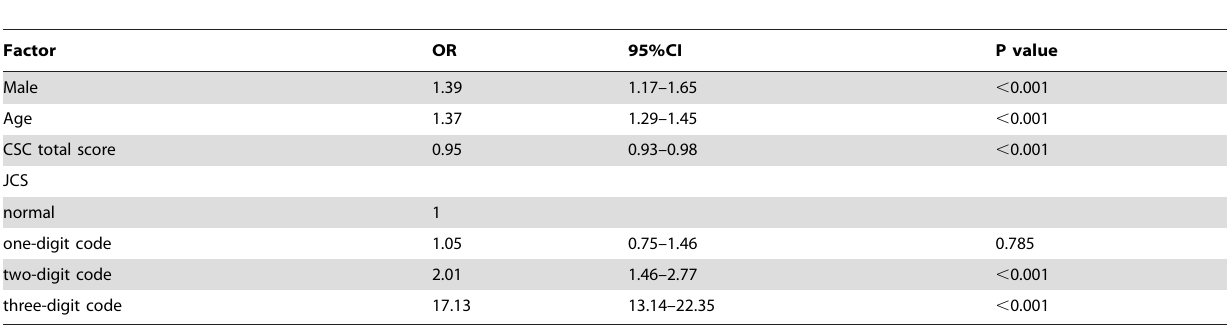
Table 6. The impact of total comprehensive stroke care (CSC) score on in-hospital mortality after subarachnoid hemorrhage, adjusted by age, sex, and level of consciousness at admission according to the Japan Coma Scale (JCS).